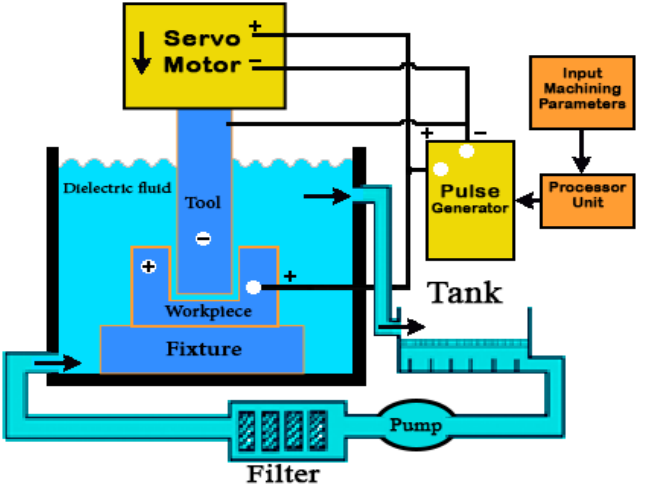
Figure 3. Schematic diagram of the die-sinking EDM.